Question: Summarize what this figure shows in one sentence.
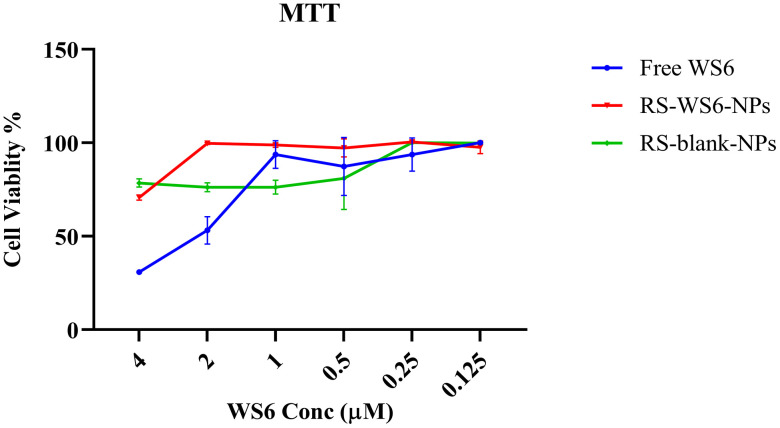
Answer: Dose–response curves (MTT assay) of stem cells from the apical papilla (SCAP) treated with free WS6, WS6-loaded(WS6-NPs), and equivalent concentrations of blank-NPs among a concentration range of 0.125–4 µM for 72hrs. Statistical analysis was performed using two-way ANOVA followed by Dunnett’s multiple comparison test (N = 3). Data are presented as mean ± SD.